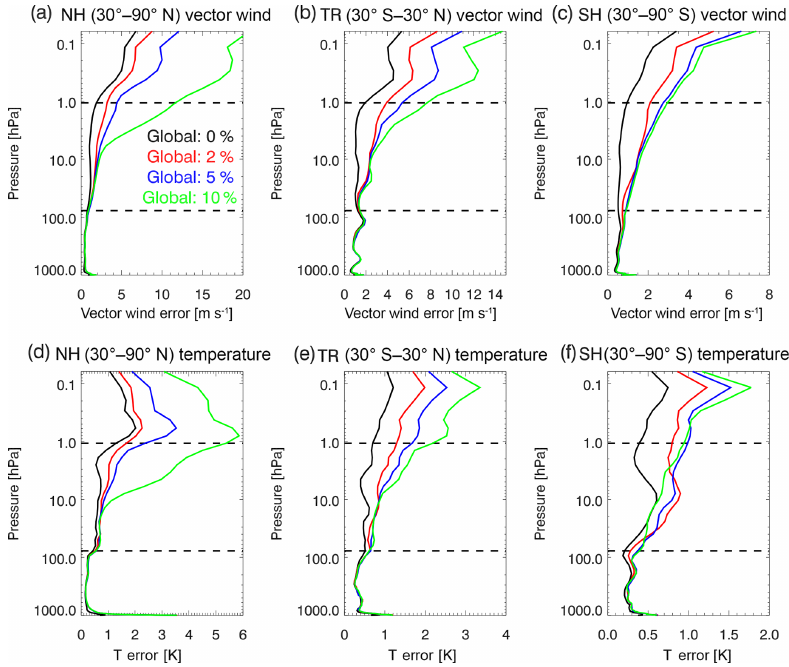
Figure 19. The rms vector wind errors (ms − 1 ) averaged from 25 November to 1 December 2014 for (a) NH, (b) TR, and (c) SH and rms temperature errors (K) for the (d) NH, (e) TR, and (f) SH. Lines are for ozone assimilation experiments for global ozone with observation errors of 0% (black), 2% (red), 5% (blue), and 10% (green). Horizontal dashed lines indicate vertical range of assimilated stratospheric ozone observations. Note that the ranges of the horizontal axes for each panel vary based on maximum errors. See Table 1, Sect. 4.4.